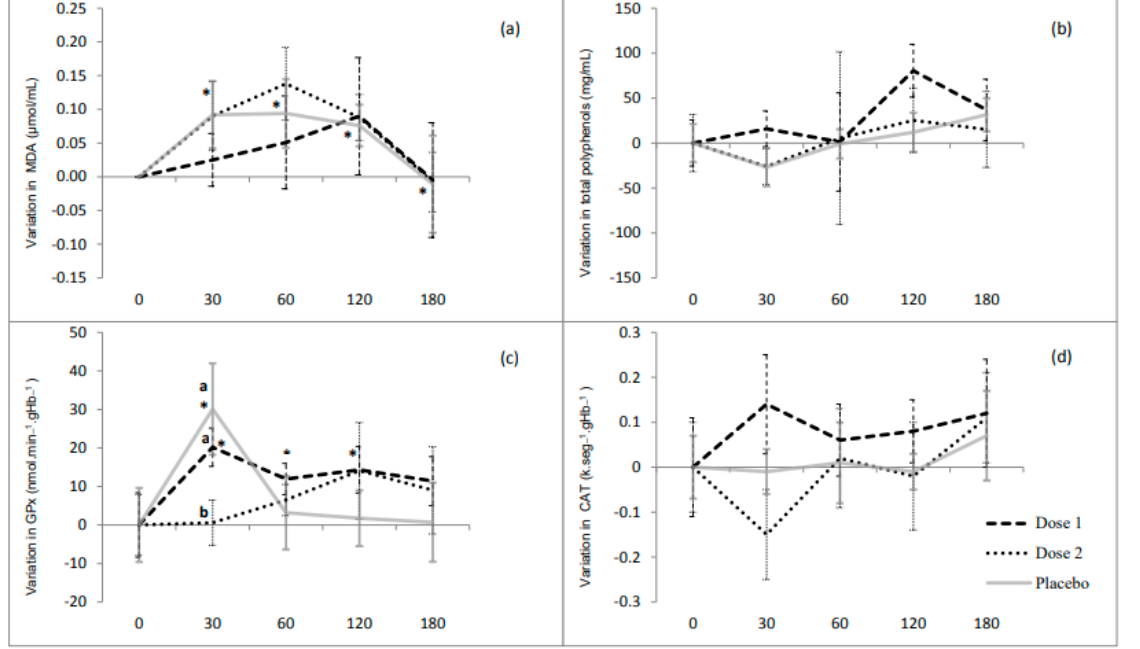
Figure 3. Variation in serum concentration of MDA ( a ), total polyphenols ( b ), GPx ( c ) and CAT ( d ) at time points of 30, 60, 120 and 180 min after ingestion of a high-fat meal in individuals with dyslipidemia, where n = 13. Lowercase letters represent differences between groups by the factorial ANOVA test with a significance level < 5%. The asterisk (*) indicates significant differences from Student’s t test for a sample in relation to a reference value (baseline) with Bonferroni correction and p < 0.01. Values are expressed as mean and standard error of the mean, represented by the error bars. MDA = malondialdehyde; GPx = glutathione peroxidase; CAT = catalase; TNF α = tumor necrosis factor alpha.